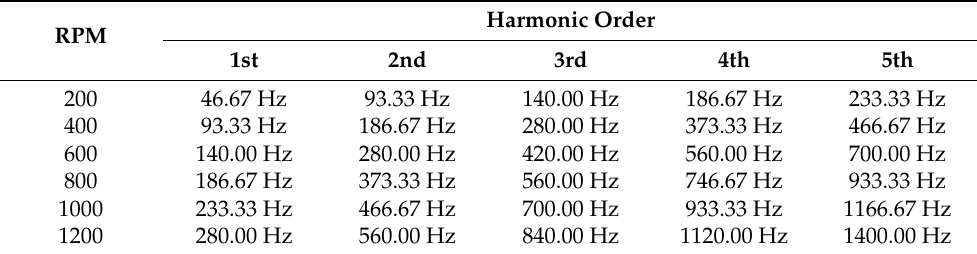
Table 3. Operating frequency of the PMSG.